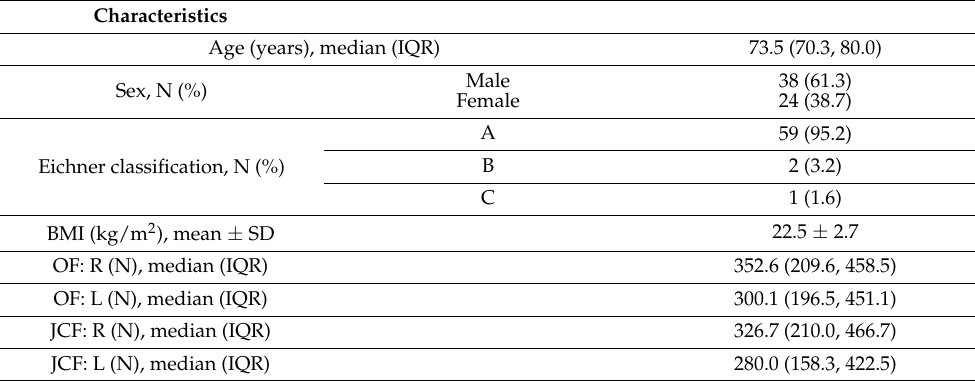
Table 2. Characteristics of participants (n =